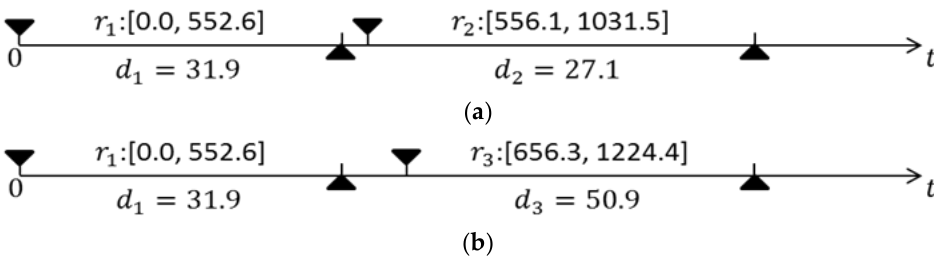
Figure 6. Examples of using an EV for multiple routes: ( a ) no need to charge at a depot; ( b ) need to be charged at a depot.